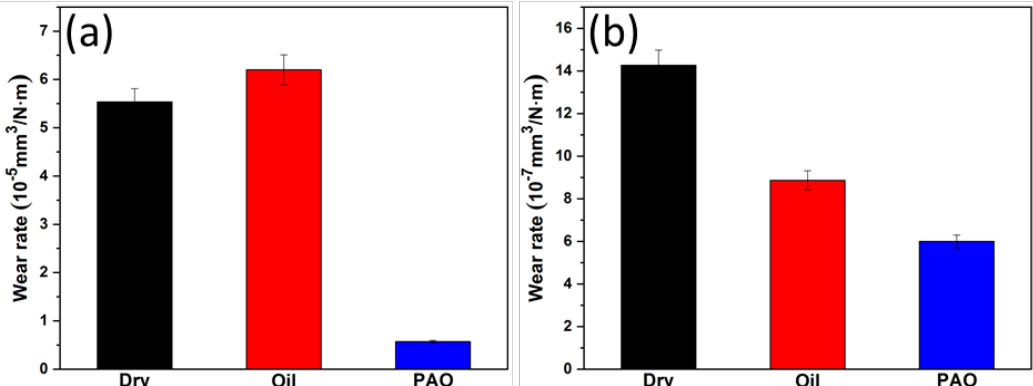
Figure 8. Specific wear rates of Al – Si substrate ( a ) and ( b ) Ni – Co – P/Si 3 N 4 composite coated speci- mens under dry conditions and lubrication with PAO and engine oil.